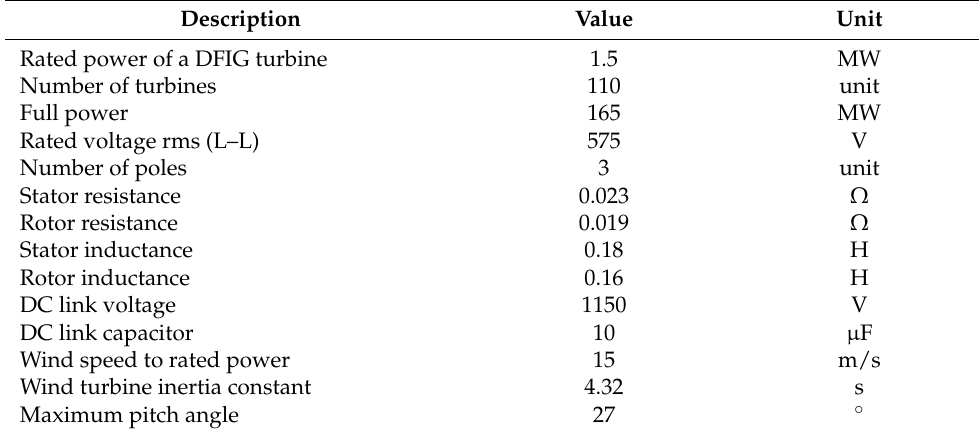
Table A1. Wind power plant parameters.